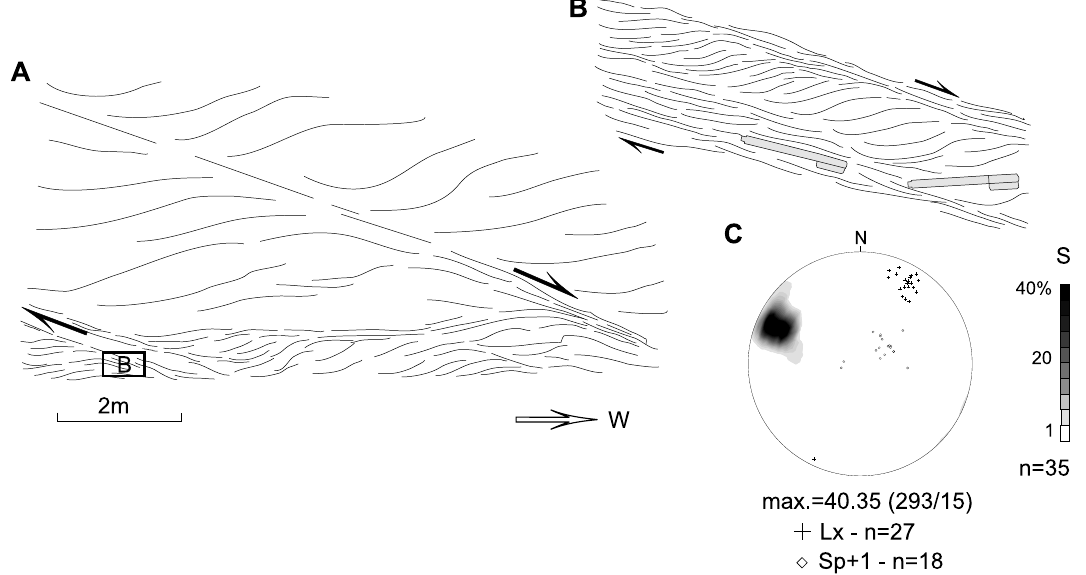
Fig. 12 – S-C foliation fabric associated with top-to-W extensional tectonics seen at metric (A) and centimetric (B) scales. These structures are related to a late-stage deformation with development of low-angle fragile surfaces which are discordant of the main foliation in the granulites (C). Banded granulite outcrop in